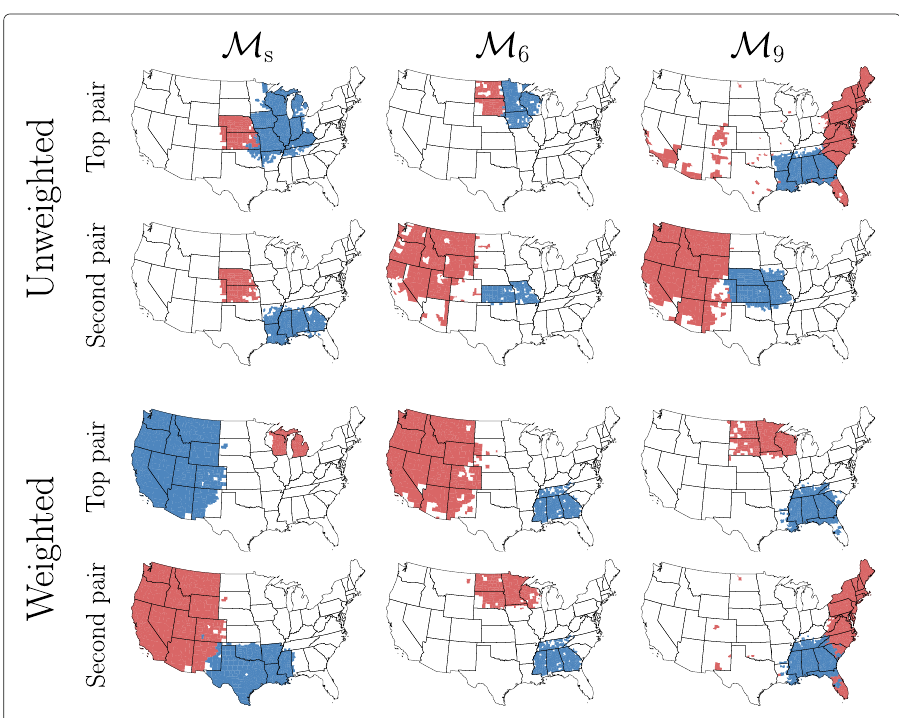
Fig. 11 Cut imbalance for functional motif-based clusterings of the US-M IGRATION network, for various motifs. For each method, the pairs of clusters with largest and second largest cut imbalance ratio are colored, with most migration flow occurring from red to blue. Top two rows: clusterings from the unweighted graph. Bottom two rows: clusterings from the weighted graph. M s corresponds to using the symmetrized adjacency